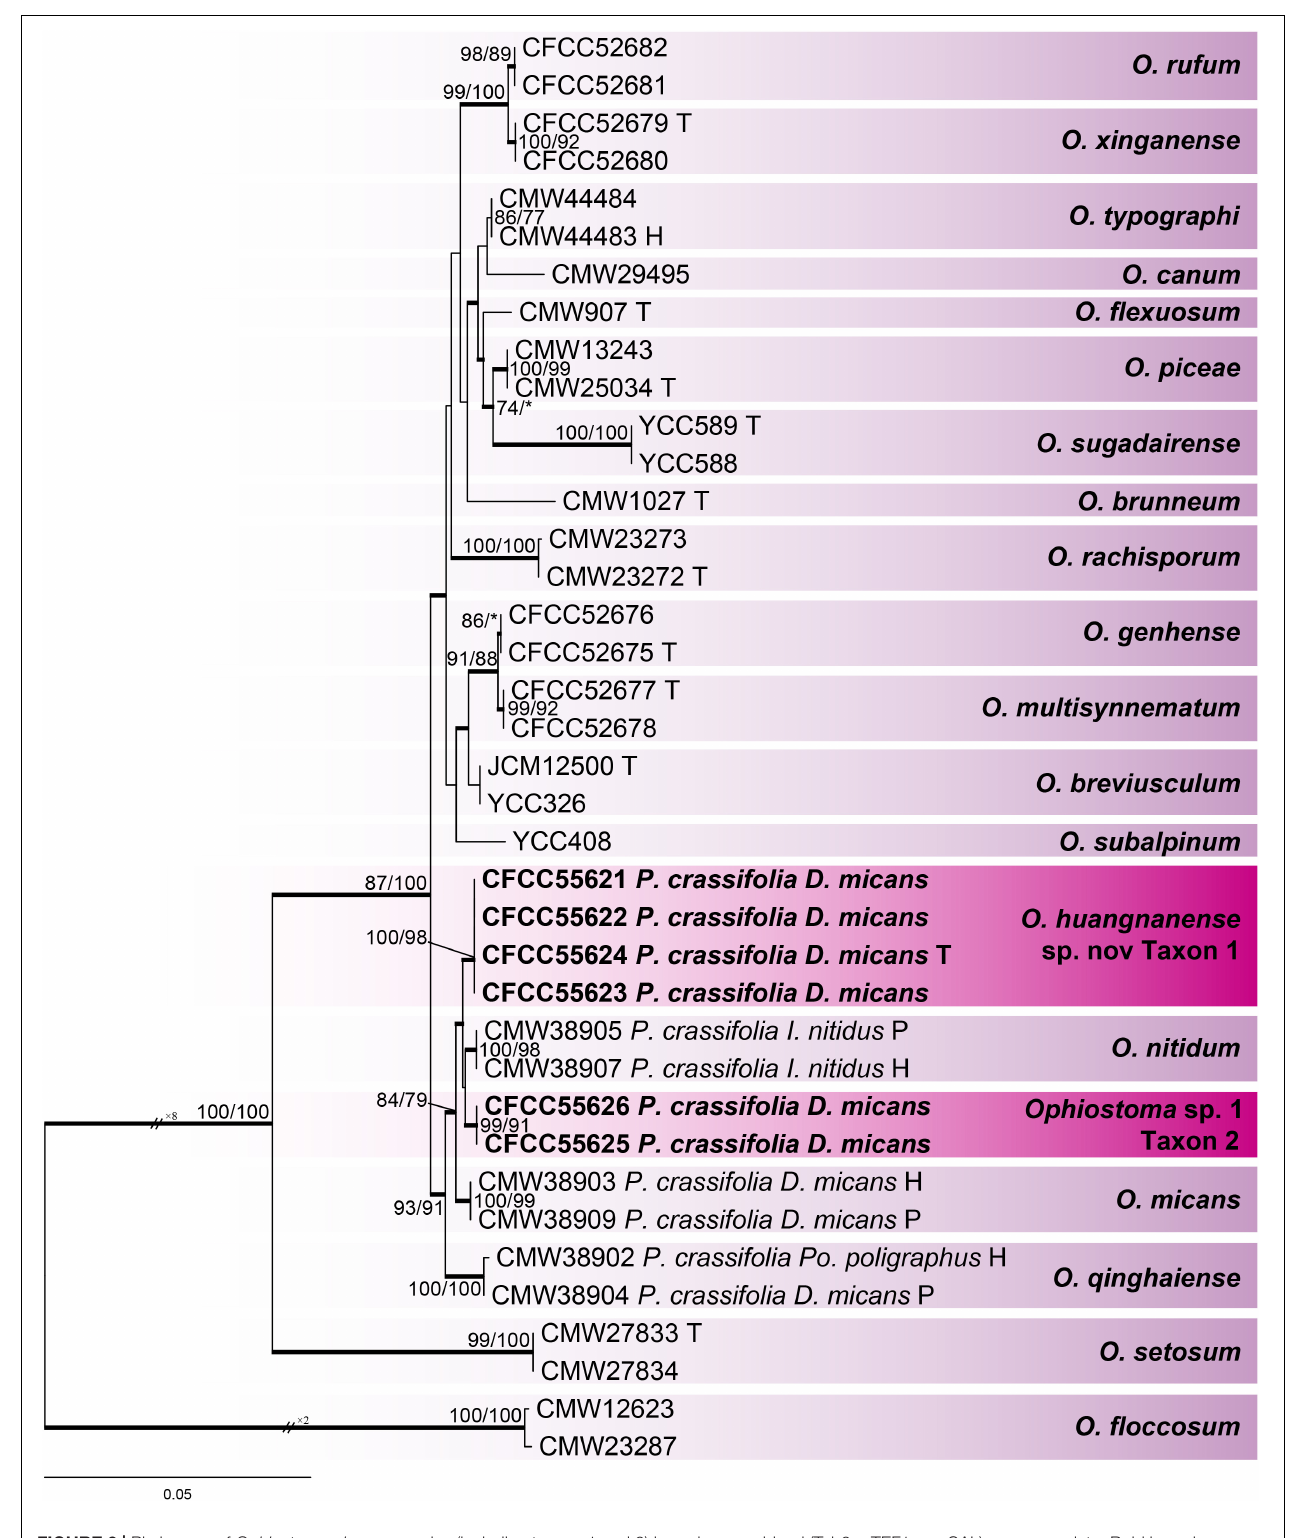
FIGURE 3 | Phylogram of Ophiostoma piceae complex (including taxons 1 and 2) based on combined (Tub2 + TEF1- α + CAL) sequence data. Bold branches indicate posterior probability values ≥ 0.9. The MP/ML bootstrap support values ≥ 70% are recorded at the nodes. D ., Dendroctonus ; P ., Picea ; Po ., Polygrphus ; H, ex-holotype; P, ex-paratype; T, ex-type